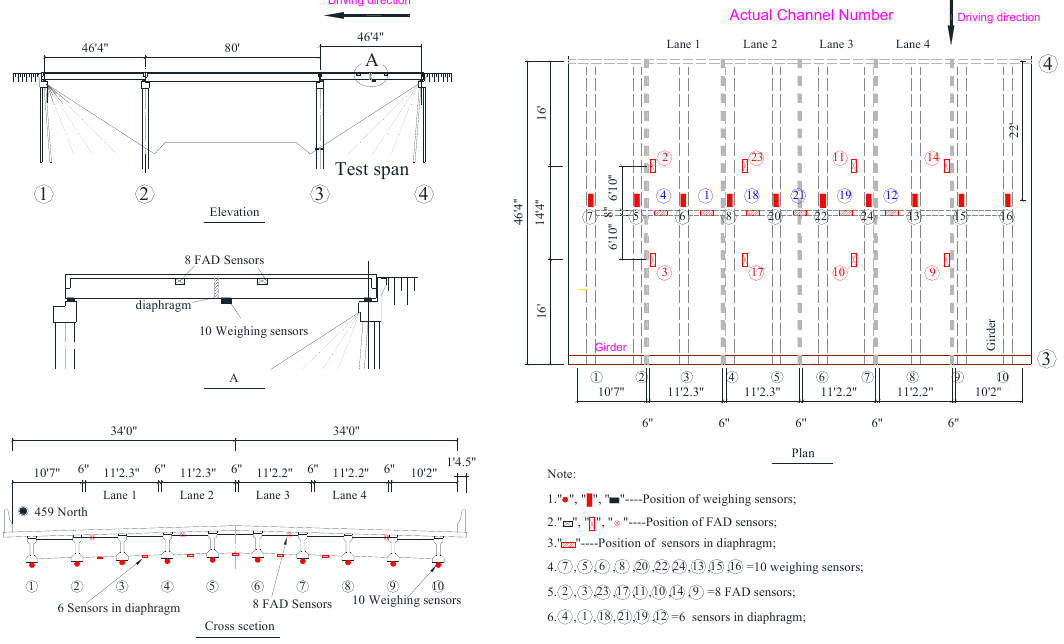
Figure 15. Geometry and sensor locations on Route 459 bridge (units: feet’ and inches”).